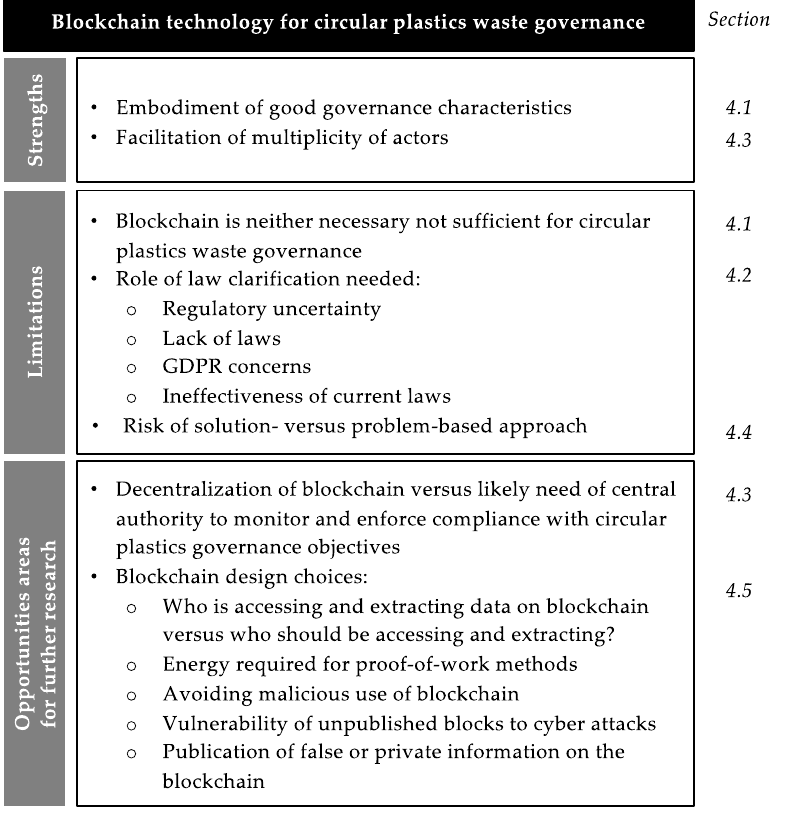
Figure 2. Overview of observations on blockchain uses for, implications for, and influences on circular plastic waste governance. This is based on online initiative and interview data evidence.